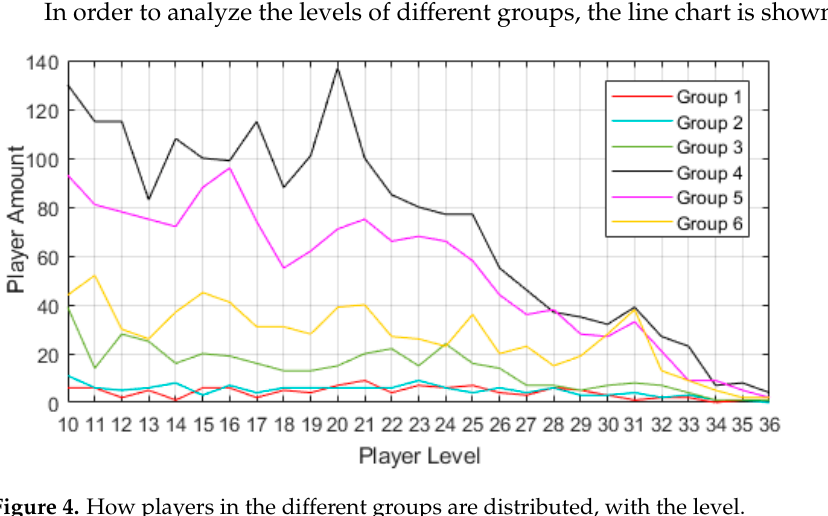
Table 1. KDA performance of the different behavior groups. Group